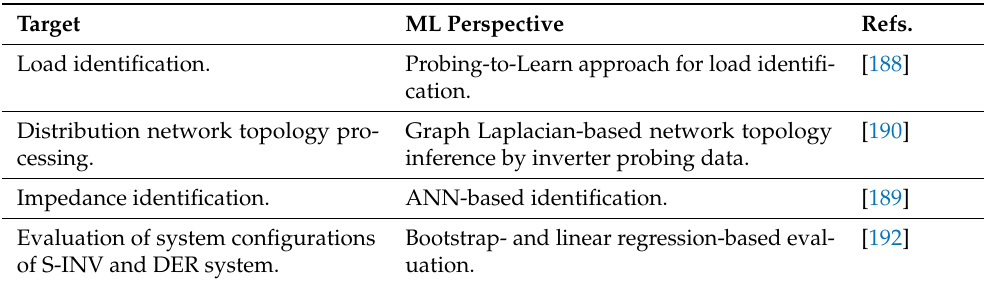
Table 7. Relevant studies on inverter